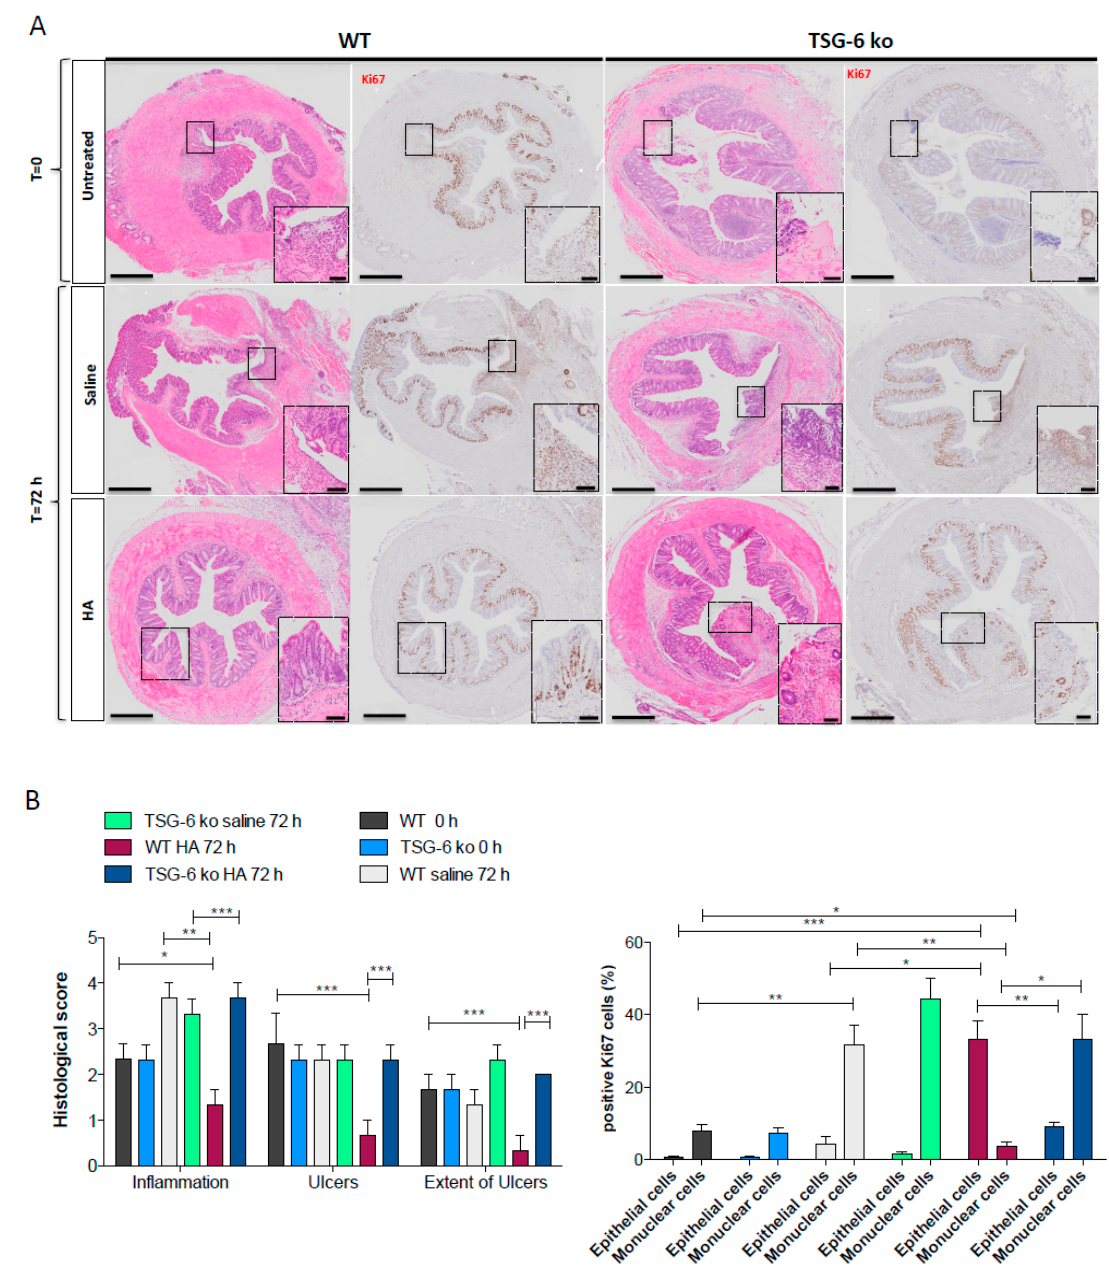
Figure 5. TSG-6 mediates HA-induced epithelial cell regeneration. ( A ). Representative photomicrographs of the intestinal mucosal wound created in the distal colon of TSG-6-deficient mice (TSG-6 ko) and their WT littermates (WT); 24 h after wounding the mice were treated daily with HA (1 mg/mL) or saline for 72 h via enema. Paraffin sections of colon were stained with HE and for the Ki67 marker to analyze the histopathological and proliferative changes during mucosal regeneration. The sections were photographed at 20× or 40× for insets ( n = 5/group); Bars = 500 μ m and 50 μ m, respectively. ( B ) (left panel) Representative histograms of the quantitative histological analysis of mucosal damage in all groups of mice; (right panel) quantitative analysis of Ki67-positive cells expressed as percentage of epithelial cells or mononuclear cells in the mucosa of all groups of mice. Data represent the means ± SEM ( n = 5/group); * p < 0.05; ** p < 0.01; ** * p < 0.001 compared to control group by one-way-ANOVA.